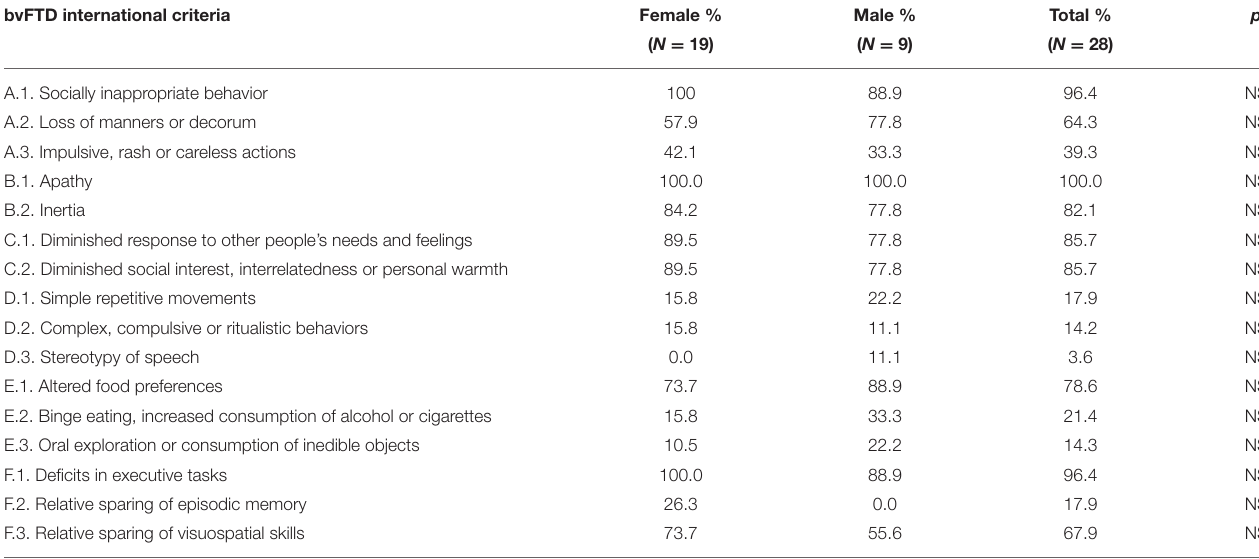
TABLE 4 | Criteria for possible bvFTD. bvFTD international